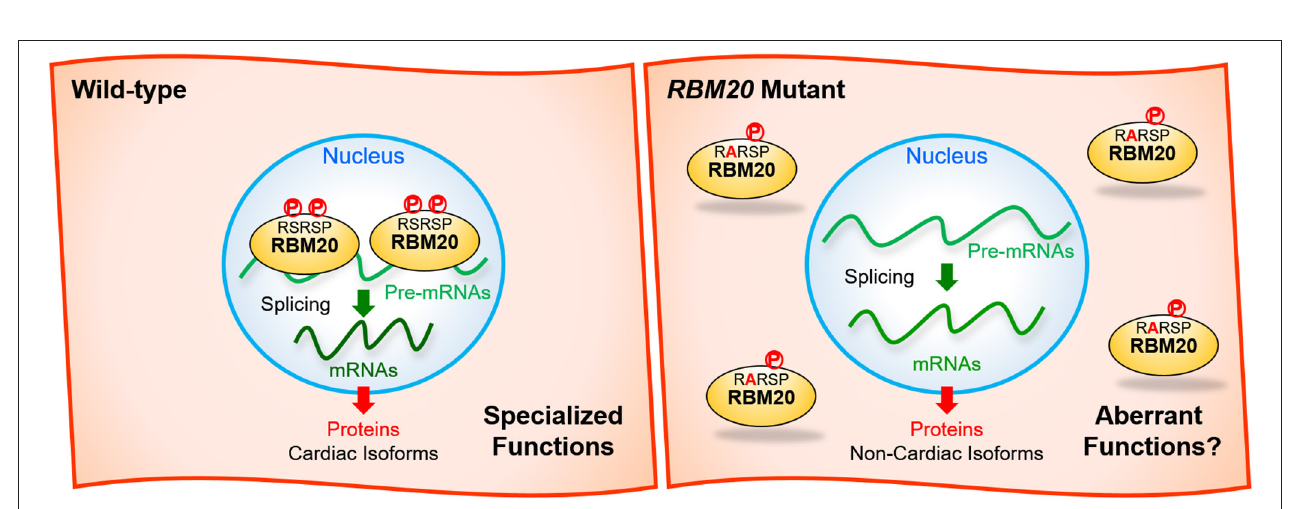
FIGURE 3 | Missense mutations in the RSRSP stretch disrupt the normal functions of RBM20. (Left) In the wild-type, two serine residues in the RSRSP stretch are phosphorylated and the RBM20 protein is localized in the nucleus, where RBM20 regulates alternative pre-mRNA splicing of its target genes so that cardiac isoforms of mRNAs are produced. The mRNAs are translated into cardiac protein isoforms with specialized functions. (Right) In the RBM20 missense mutant with a substitution in the RSRSP stretch, the mutant RBM20 proteins are no longer imported into the nucleus. Pre-mRNAs of the RBM20-target genes are processed into non-cardiac isoforms of mRNAs, which are then translated into non-cardiac protein isoforms, which may lack the specialized functions and/or exert aberrant functions. The mutant RBM20 proteins retained in the cytoplasm may also exert aberrant functions. P,